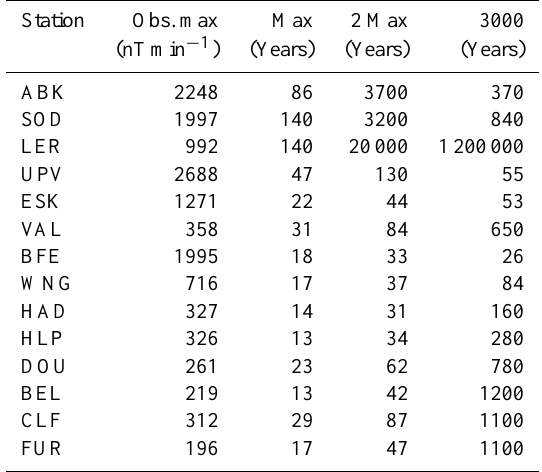
Table 2. The observed maxima (Obs. max) and the return periods, in years, for the different stations to levels of observed maxima (Max), two times observed maxima (2 Max), and fixed 3000nTmin − 1 level